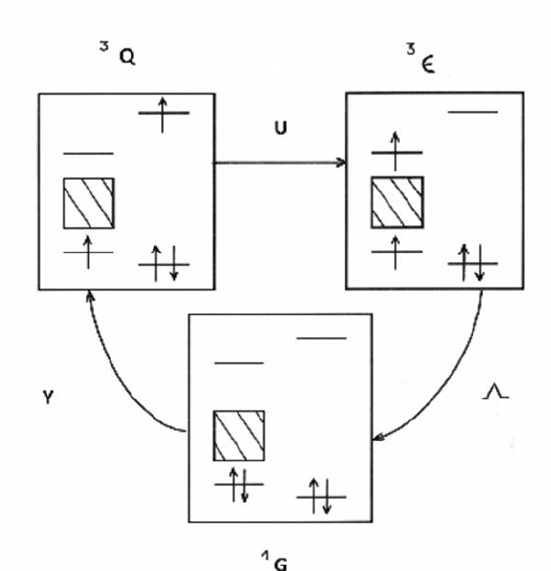
Figure 12 . A Triplet Channel: An example of a solid valence electron jumping on the molecular u state by hyperfine contact (a single-electron excitation). The shifted electron and its remaining pair in the solid build a magnetic electronic state that flips the nuclear spins. The electron repulsion brings back the shifted electron to the solid through the molecule-solid bridge (the bonding of the antibonding states) emitting (or not) an exciton. Finally the spin-orbit interaction brings back the solid to its original ground